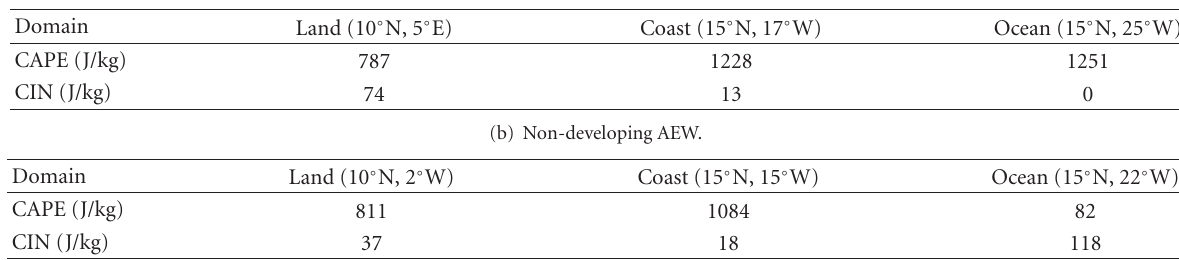
Table 1: CAPE and CIN values in the case of the AEW associated with a cyclone (a) and in the case of the non-developing AEW (b) over land, over the coast, and over the